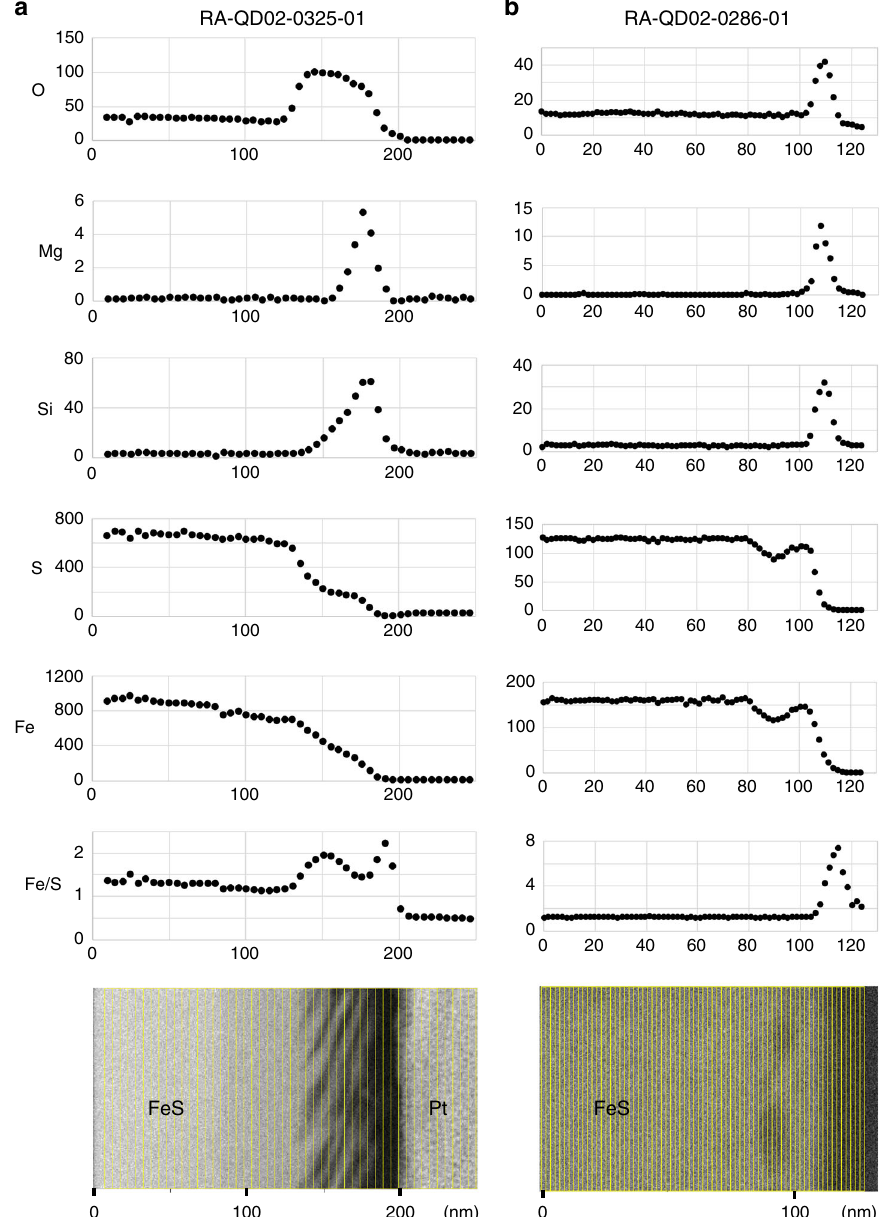
Fig. 4 Depth pro fi les of major elements detected near the troilite surface. X-ray intensity counts of O, Mg, Si, S, Fe and the count ratio of Fe/S near the troilite surface with ( a ) open vesicles and with ( b ) internal vesicles are shown. The vertical axis is X-ray count and the horizontal axis is distance (nm). The lower sub fi gure is a BF-STEM image of investigated area corresponding to upper count pro fi les. a was obtained from a FIB section RA-QD02-0325-01 (Supplementary Fig. 1). b was obtained from FIB section RA-QD02-0286-01 (Supplementary Fig.